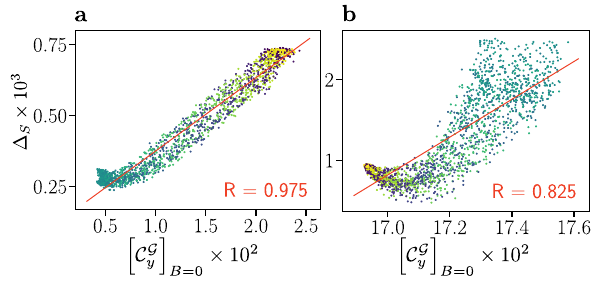
Figure 4. Compass anisotropy (cid:31) S as a measure of compass sensitivity is plotted against the global measure of coherence [ C G y ] B = 0 , an operational measure that represents the coherence contribution of the total nuclear and electronic state to the singlet yield evaluated in the absence of a magnetic field. ( a ) Correlation plot for the flavin–tryptophan model. ( b ) Correlation plot for flavin–tyrosine model. Data has been coloured according to the radical relative orientation angle β , ranging from 0 ◦ (blue) to 180 ◦ (yellow), and a linear fit (red line) with associated Pearson correlation coefficient R is